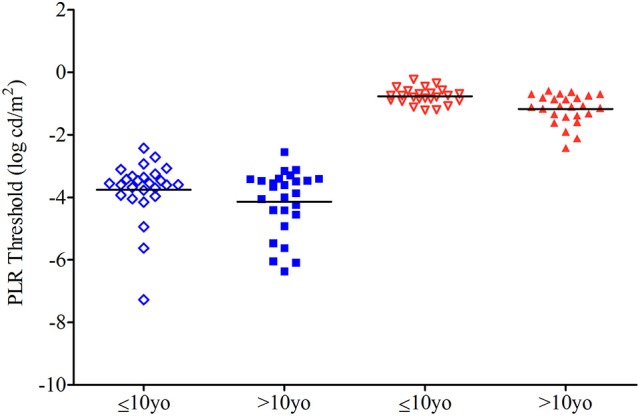
Dot plot of the threshold for 26 subjects of the younger group and 26 from the older one. Threshold intensity is the light intensity needed to produce a 5% contraction amplitude using a regression line. See Figures 1, 2. Horizontal bars represent the mean for younger (open symbols) and older (closed symbols) groups.